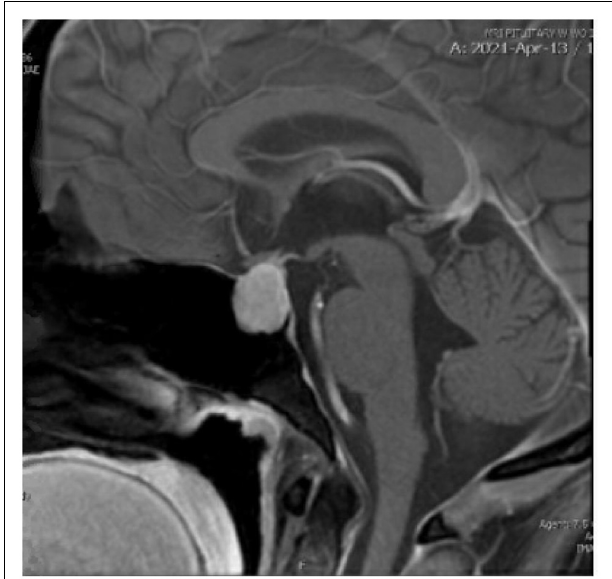
FIGURE 1 | The patient’s initial MRI with pituitary